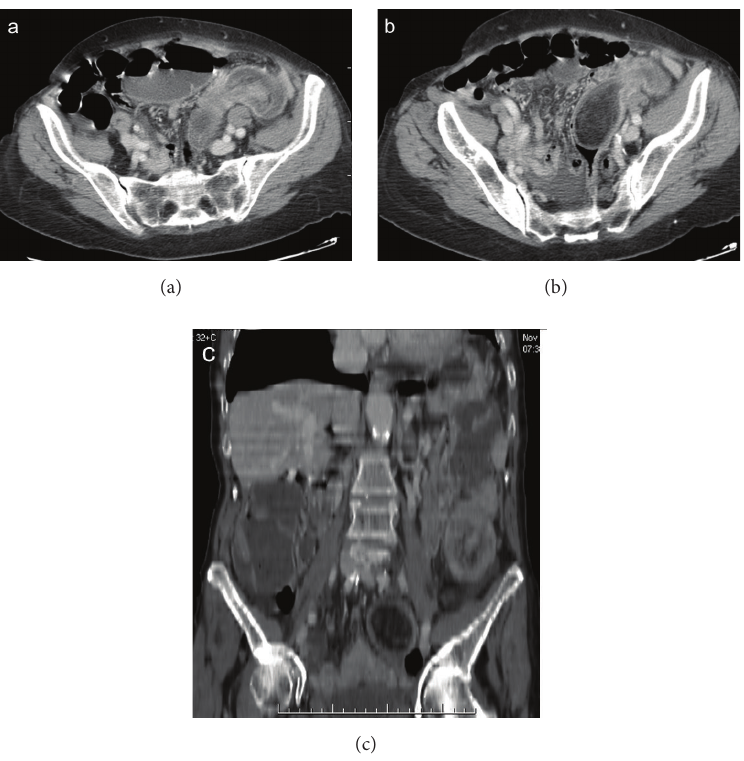
Figure 11: Colocolonic intussusception caused by a sigmoid lipoma. The intussusception is well depicted on axial CT scan (a). Both axial scan (b) and coronal reformatting (c) show the hypodense polypoid mass that acts as the lead point.